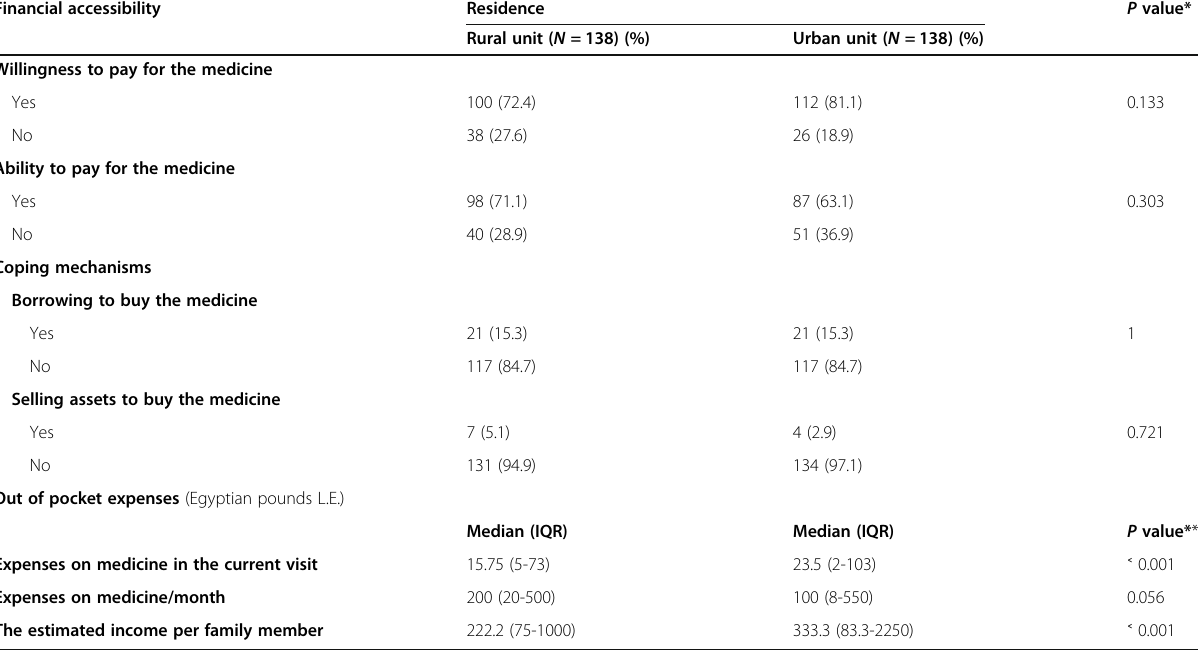
Table 2 Factors associated with patients ’ financial accessibility to the essential drug list among rural and urban groups attending PHC units, Giza Governorate, Egypt, 2019